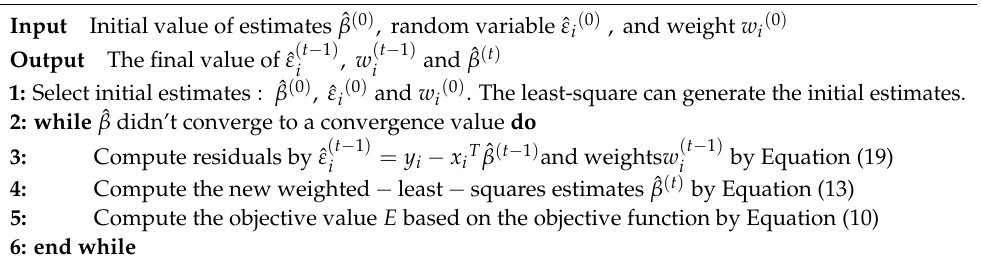
Algorithm 2 The IRLS algorithm using Tukey’s bisquare